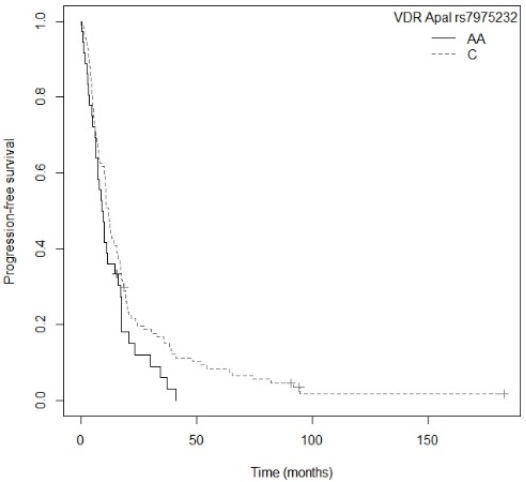
Figure 9. Kaplan–Meier plot of progression-free survival curves with the C allele of the CYP24A1 rs6068816 gene polymorphism in the non-resected NSCLC subgroup.